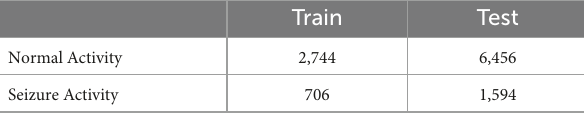
TABLE 4 Number of training and testing dataset for dataset 2.